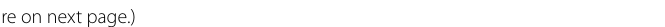
0.001(See figure on next Fig. 6 LncRNA SNHG1 regulated SFRP1/Wnt signaling pathway by interacting with miR‑181c‑5p. A StarBase analysis showed the predicted miR‑181c‑5p binding sites in the 3 ′ UTR of SFRP1 mRNA. B Dual luciferase reporter assay performed to verify the association of miR‑181c‑5p and SFRP1. C The BMSCs were transfected with miR‑181c‑5p mimics or miR‑NC for 48 h, the expression level of SFRP1 was detected by qPCR. D–F The BMSCs were transfected with miR‑NC, miR‑181c‑5p mimics, miR‑181c‑5p mimics with vector NC, miR‑181c‑5p mimics with SFRP1vector for 48 h. The mRNA level of SFRP1 was detected by qPCR ( D ), the protein levels of SFRP1, Wnt3a and β‑catenin were detected with western blot ( E ), the cytoplasmic and nuclear expression of β‑catenin were observed by immunofluorescence ( F ). G and H After transfection with vector‑NC, SNHG1 vector, SNHG1 vector with miR‑NC, SNHG1 vector with miR‑181c‑5p mimics for 48 h, the mRNA and protein expression of SFRP1, Wnt3a and β‑catenin in BMSCs were assessed through qPCR and western blot, respectively. * P < 0.05, ** P < 0.01, *** P <